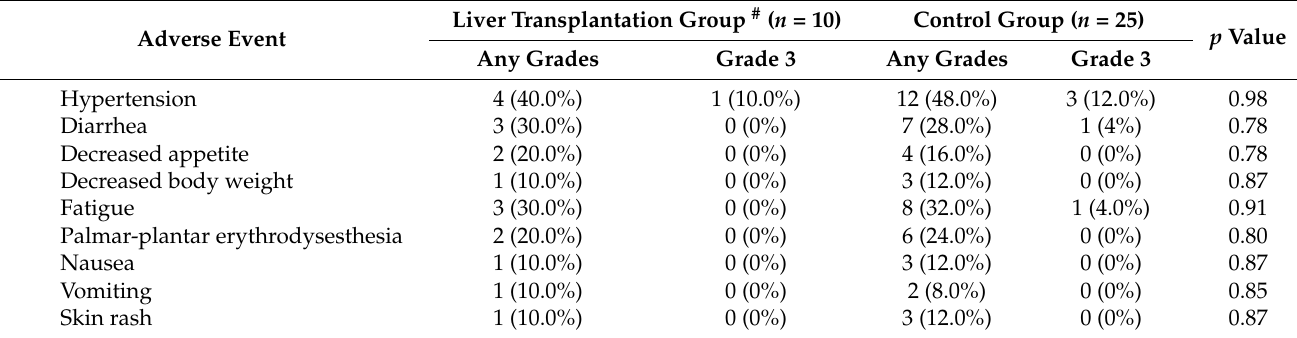
Table 4. Lenvatinib-related adverse events in the 35 patients with unresectable hepatocellular carcinoma. Liver Transplantation Group # ( n = 10) Control Group ( n = Adverse Event